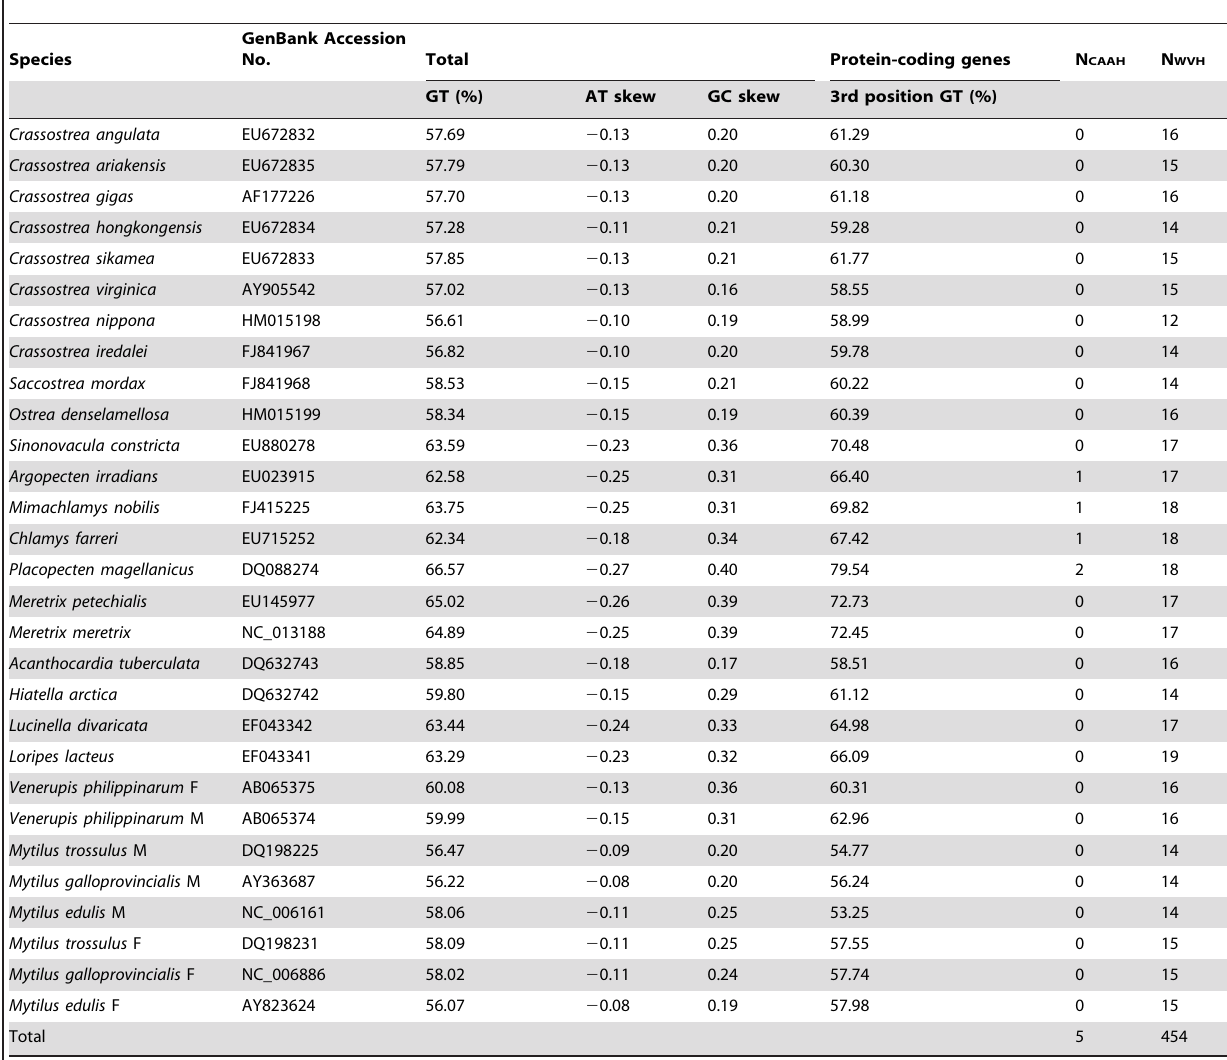
Table 1. Nucleotide biases of the total genome and protein-coding genes, and number of codon families unambiguously supporting the codon-anticodon adaptation hypothesis (N CAAH ) and the wobble versatility hypothesis (N WVH ) in each marine bivalve mitochondrial